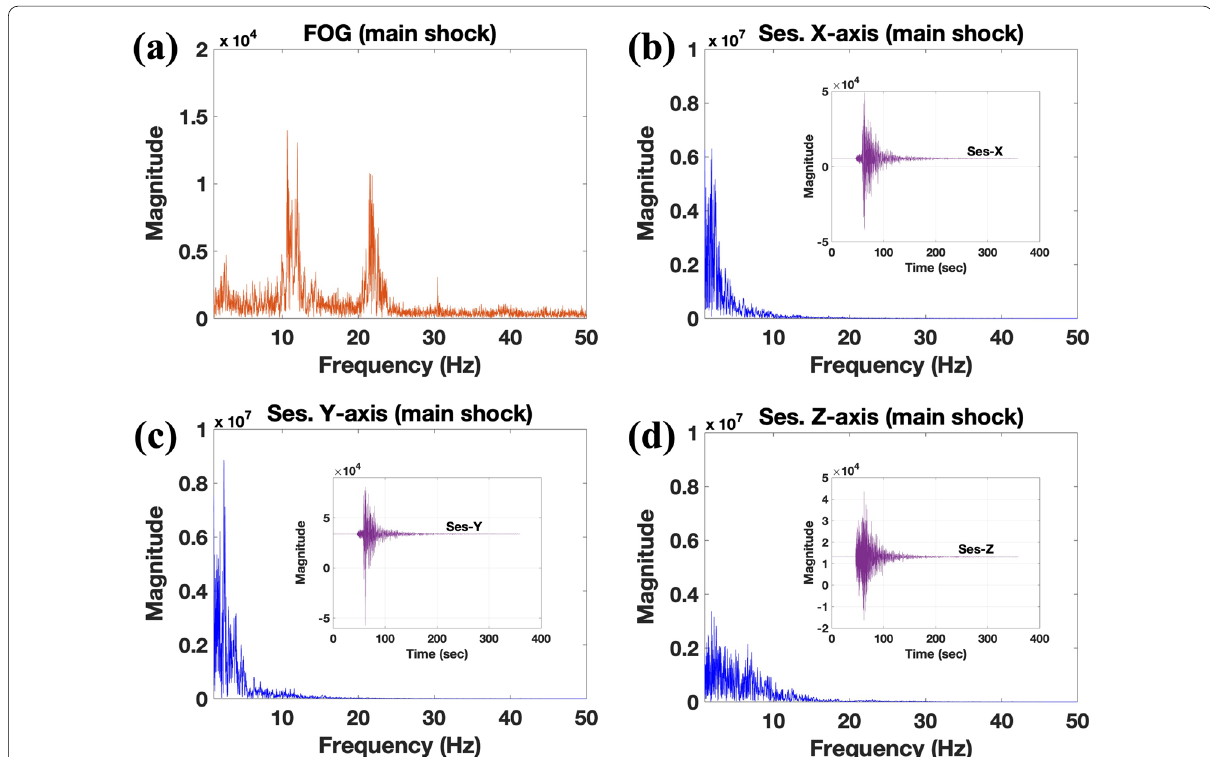
Fig. 3 Fast Fourier transform of the recorded main shock data from a NCU‑FOG and b – d seismograph (SMART 24A) in X‑axis, Y‑axis, and Z‑axis, respectively. The insets of b – d are the corresponding raw data recorded by the